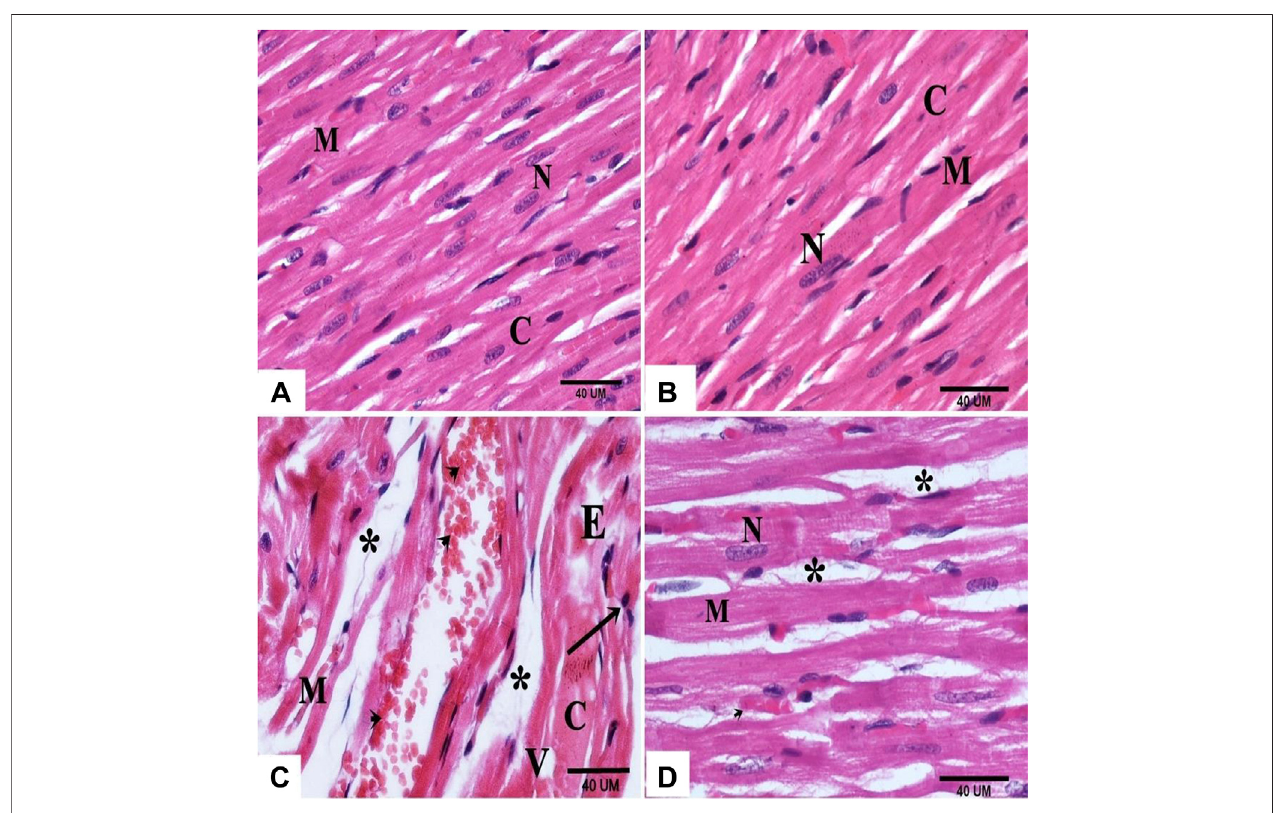
FIGURE 3| photomicrographs ofsections in the rat myocardium (A and B) From group (I) and group (II) respectively show intact cardiac muscle fi bers (M), central nucleus (N)and acidophilic cytoplasm (C) . Group (III) shows structural changes; fragmented (M) and separated (*) cardiac muscle fi bers, vacuolation(V), edema (E), pale cytoplasm (C), pyknotic nuclei (arrow) and extravasated RBC ʾ s (arrow head). (D) Group (IV) shows normal myocardial structure except some cardiac muscle fi bers (M) with central nucleus (N) and wide spaces (*).